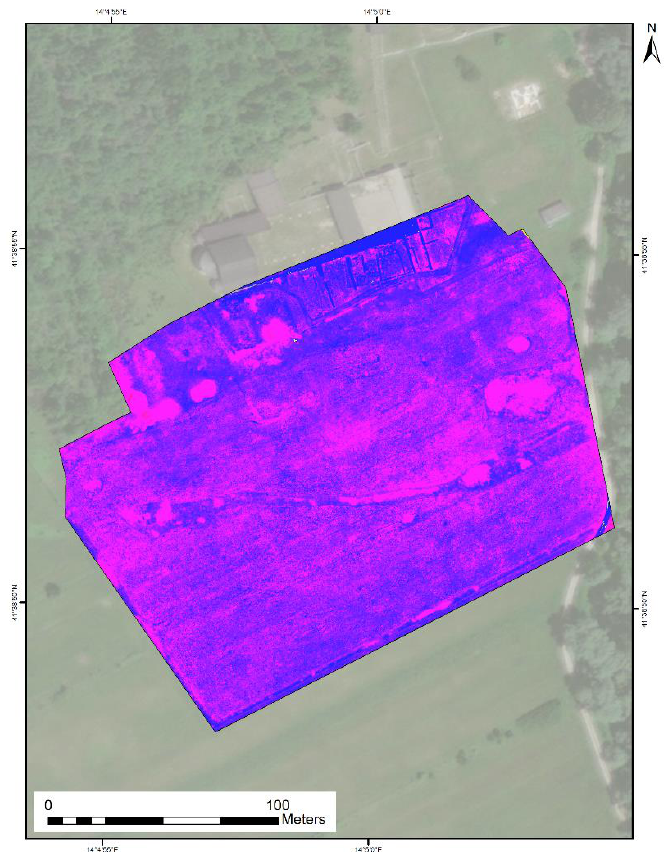
Figure 11. R: 1st PC; G: 2nd PC; B: 3rd; SPCAs obtained using correlation-matrix method. In this case, the most significant bands were autoptically selected from those generated and used for the recognition of features of possible archaeological interest, as is shown in the Figure 12 where R: 4th PC; G: 23th PC; B: 27th PC.